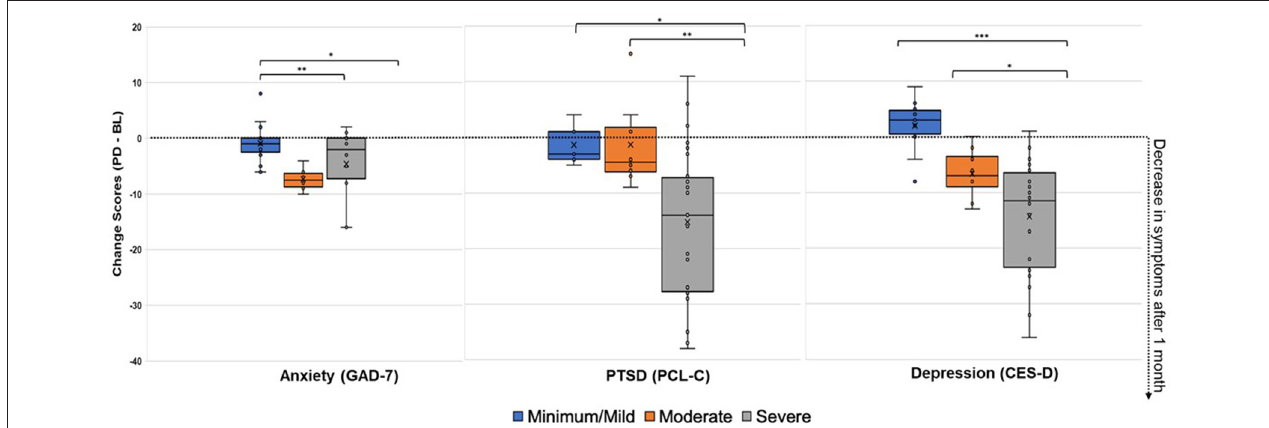
FIGURE 3 | Change Scores After 1-Month on the Low Glutamate Diet (Post-diet minus Pre-diet) for Anxiety, PTSD, and Depression Symptoms. Positive change scores indicate increased reporting of symptoms at post-diet, while negative change scores indicate decreased reporting of symptoms at post-diet (improvement). Minimal/mild, Moderate, and Severe categories were determined by baseline symptom severity. ANOVA LS Mean Difference: * p < 0.05, ** p < 0.01, *** p < 0.001.